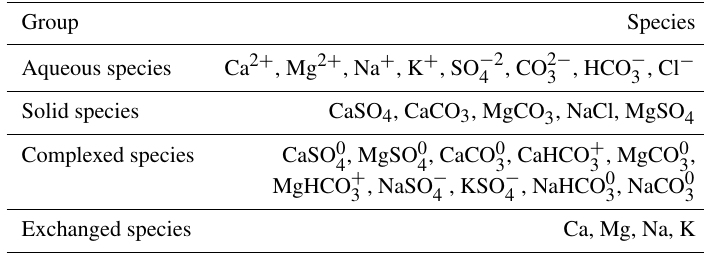
Table 1. Groups and species included in the Salinity Equilibrium Chemistry (SEC) module for